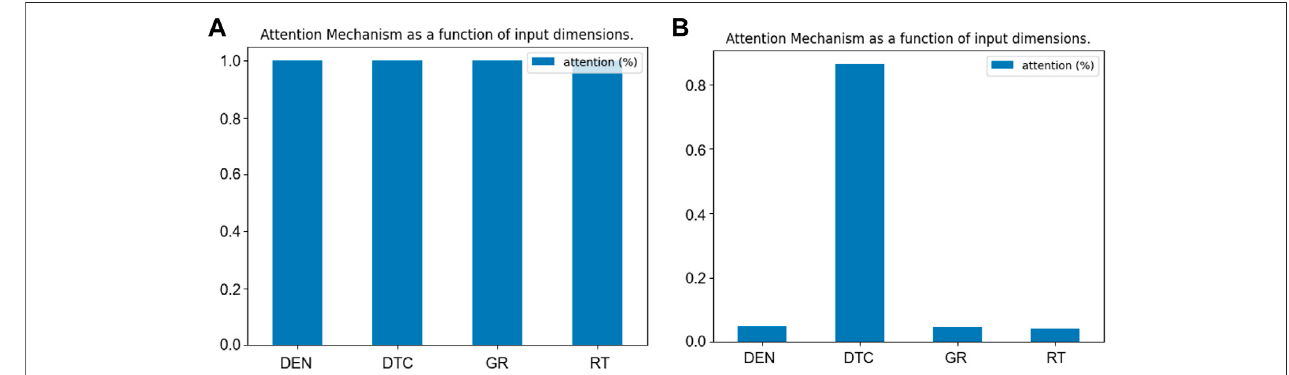
FIGURE 6 | (A) The importance of each feature by default. (B) The importance of each feature after the attention mechanism algorithm.